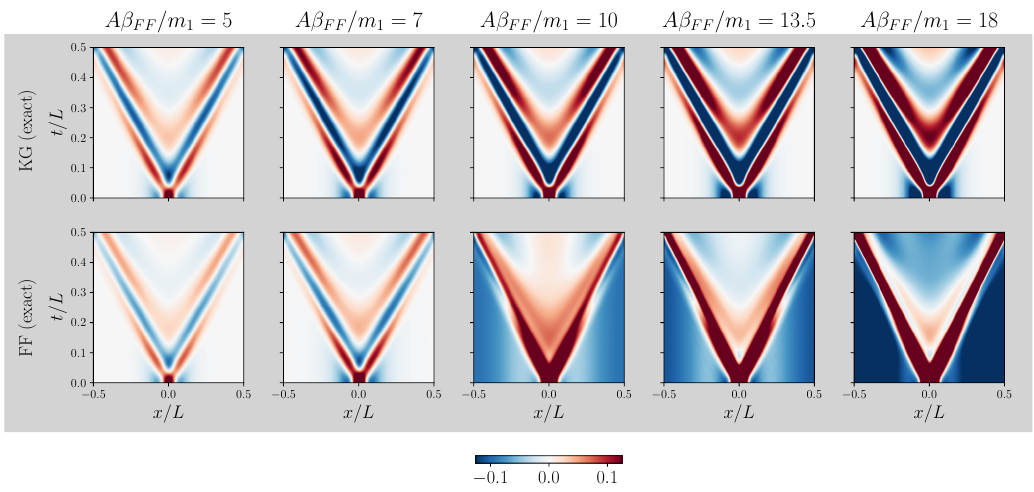
Figure 4.10: Comparison of the time evolution in the Klein–Gordon and free fermion limits for small amplitudes of the initial inhomogeneity.